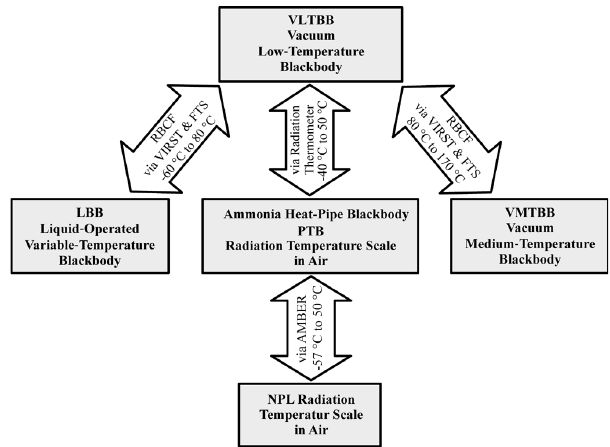
Fig. 10. Difference between the radiation temperatures of the VLTBB and the LBB at 0 ◦ C measured with the vacuum FTS (blue line) in the relevant wavelength range of the GLORIA instrument and with VIRST (red line) at the RBCF.